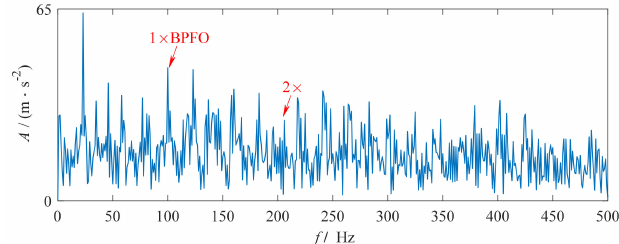
Figure 18. Result by RVMD with the traditional definition of kurtosis for the signal from the Curtin University.